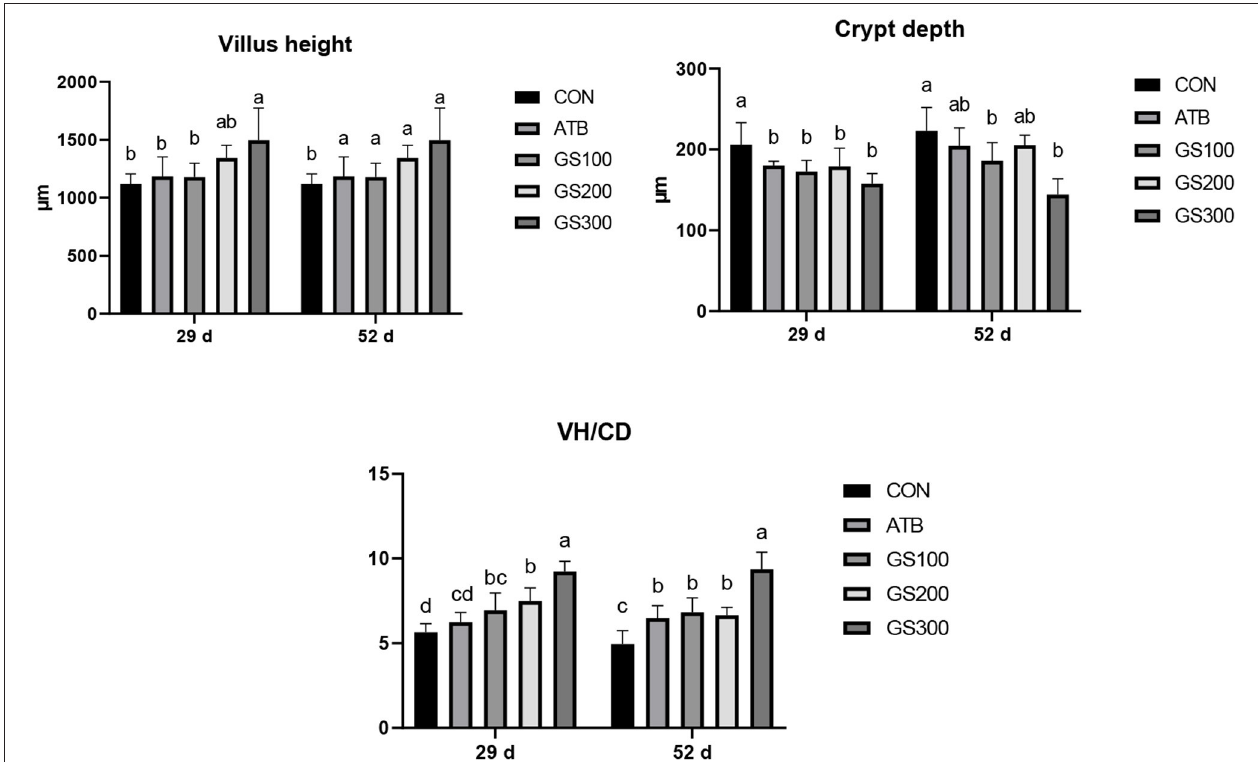
FIGURE 3 | Effects of ginsenoside Rg1 on jejunal morphological structure at day 29 and day 52 in broiler chickens ( n = 6). CON, birds fed a basal diet; GS100, birds fed a basal diet supplemented with 100 mg/kg ginsenoside Rg1; GS200, birds fed a basal diet supplemented with 200 mg/kg ginsenoside Rg1; GS300, birds fed a basal diet supplemented with 300 mg/kg ginsenoside Rg1; ATB, a basal diet supplemented with 300 mg/kg chlortetracycline. Data were shown as means ± standard deviations. Mean value without the common letter on the data bar in each figure indicated that the difference was significant ( P < 0.05).